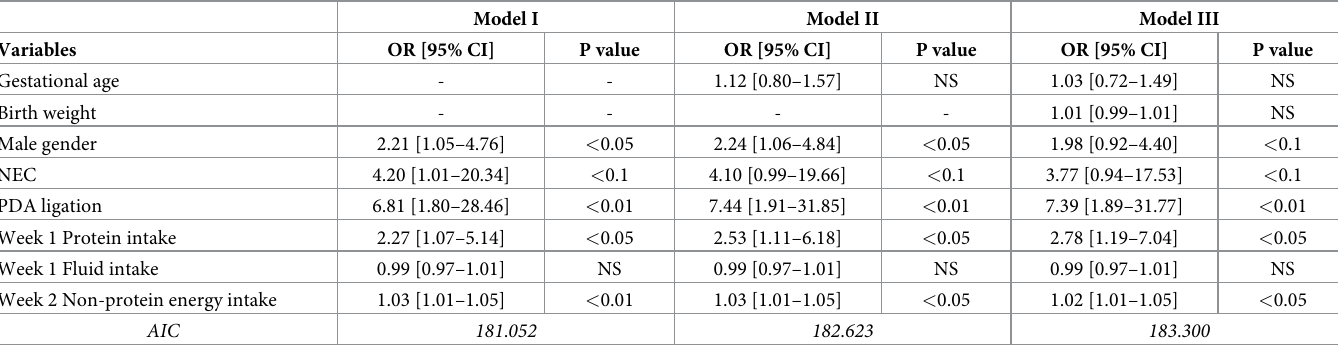
Table 2. Multivariable logistic regression analysis of the primary outcome of neurodevelopmental impairment at 2 years’